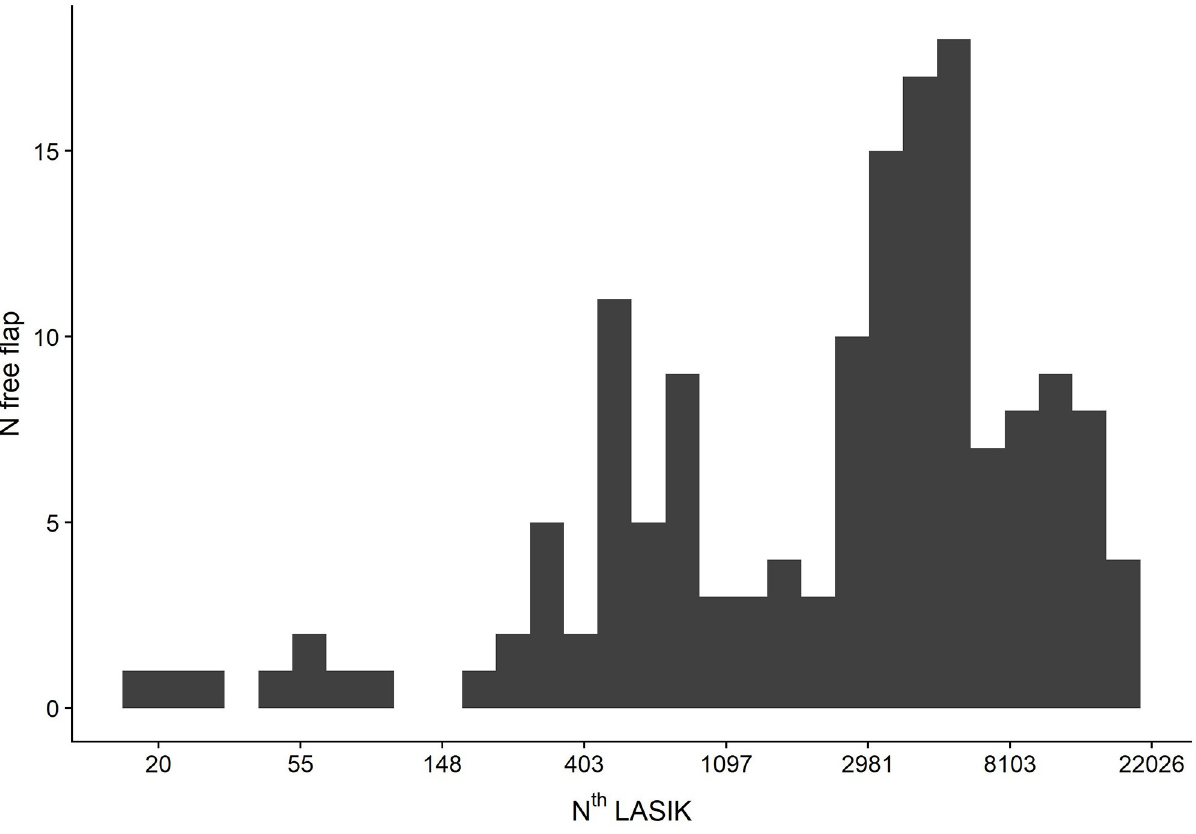
Fig 4. Surgeons’ experience and free flap